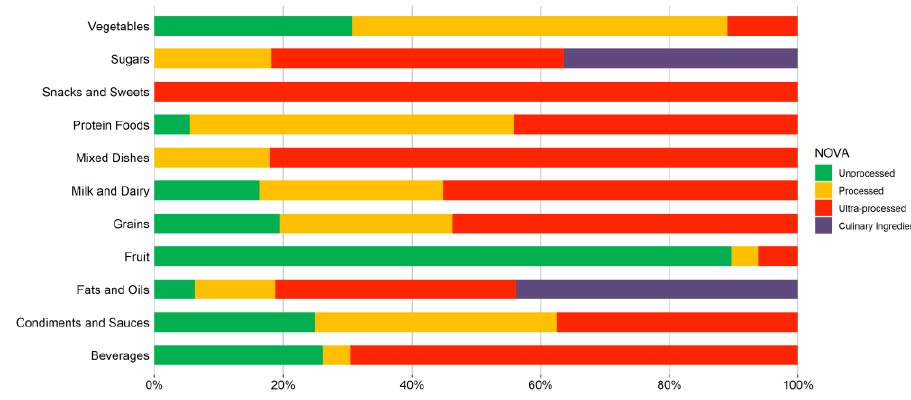
Figure 2. NOVA categories by food group.